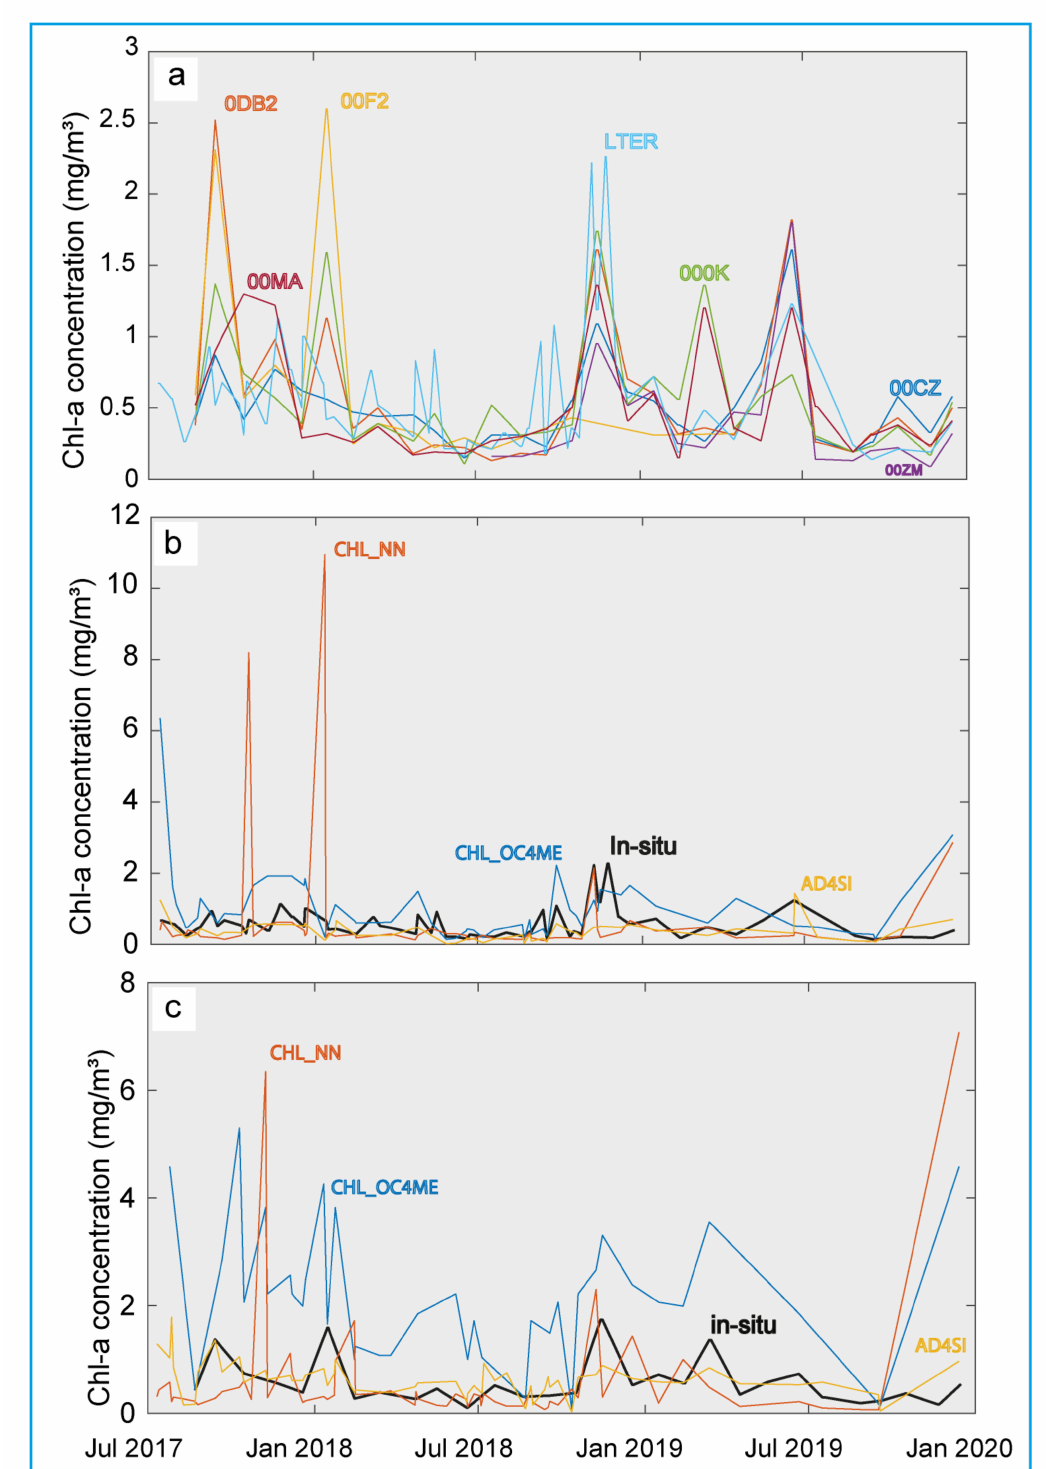
Figure 4. ( a ) Time series of in-situ Chl- a concentration for all stations considered (see Figure 1). ( b ) Time series for the LTER site. In-situ data are shown in black and selected OLCI-derived concentrations are shown in the respective colors (only values for the dates considered are shown). ( c ) Time series for station 000K. The in-situ data are shown in black and the OLCI products in the respective colors (only values for the dates considered are